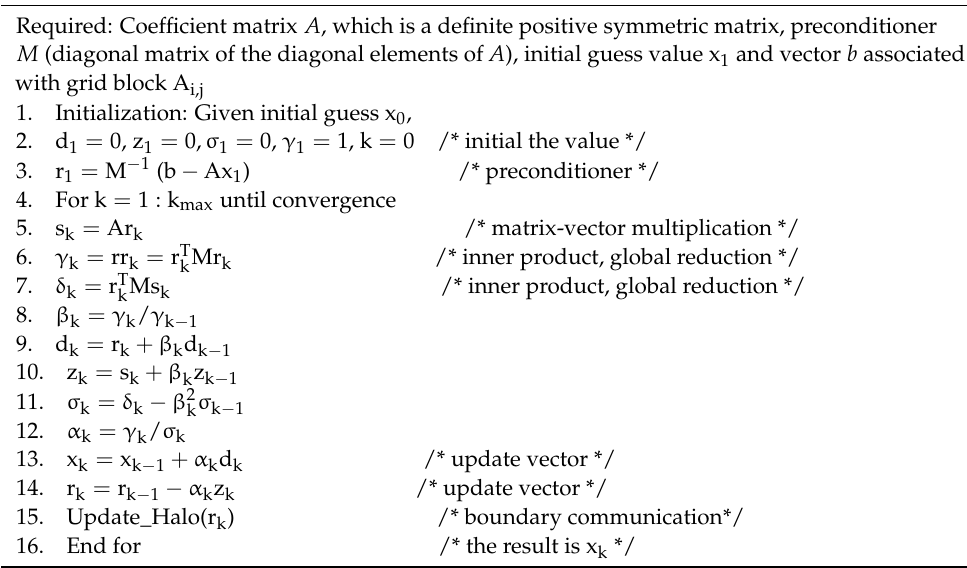
Algorithm A1. Preconditioned conjugate gradient (PCG)